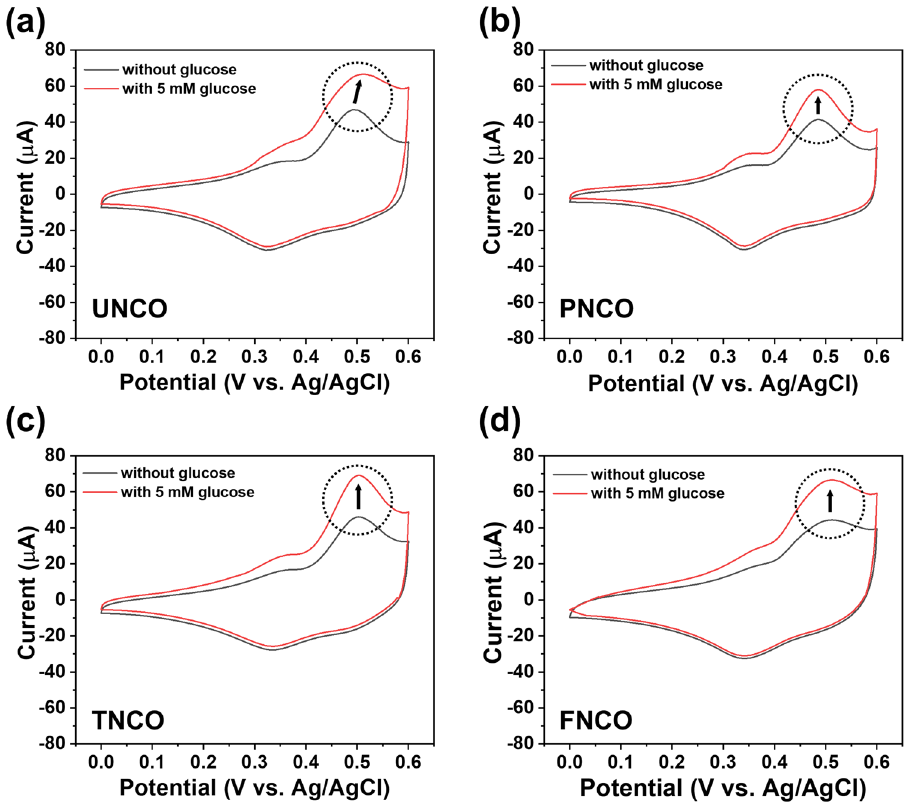
Figure 5. CV curves of ( a ) UNCO, ( b ) PNCO, ( c ) TNCO, and ( d ) FNCO electrodes in the absence of glucose and with the addition of 5 mM glucose at a scan rate of 50 mVs −1